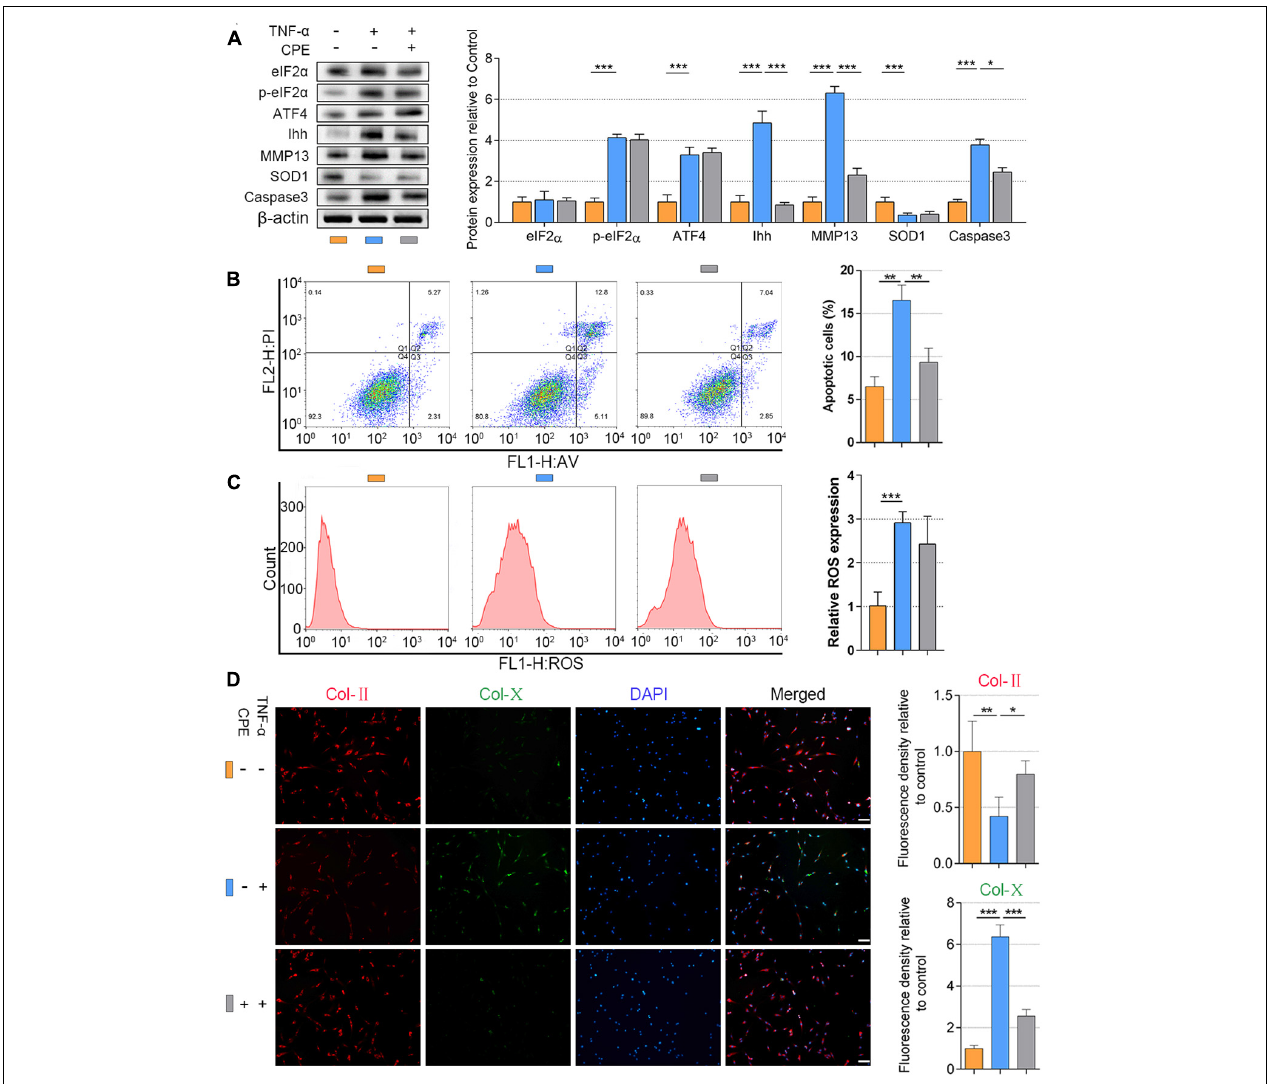
FIGURE 5 | Inhibiting Ihh expression decreased hypertrophy and apoptosis in human NP cells. NP cells were treated with 20 ng/ml of TNF- α for 3 days or simultaneously applied CPE. (A) eIF2 α , p-eIF2 α , ATF4, Ihh, MMP13, SOD1, and Caspase3 protein levels were assessed by WB, measured by densitometric analyses, and expressed as folds relative to control. Flow cytometry assay and the corresponding statistical analysis of (B) cell apoptosis (%) and (C) ROS expression. (D) Representative images of IF staining with Col-II and Col-X, measured by densitometric analyses and expressed as folds relative to control (scale bar = 100 µ m). Data are presented as means ± SD ( n = 7). * p < 0.05; ** p < 0.01; *** p < 0.001; the orange column indicates control NP cells without any treatments, the blue column indicates NP cells treated with TNF- α , and the gray column indicates NP cells treated with TNF- α and CPE. Ihh, Indian hedgehog;